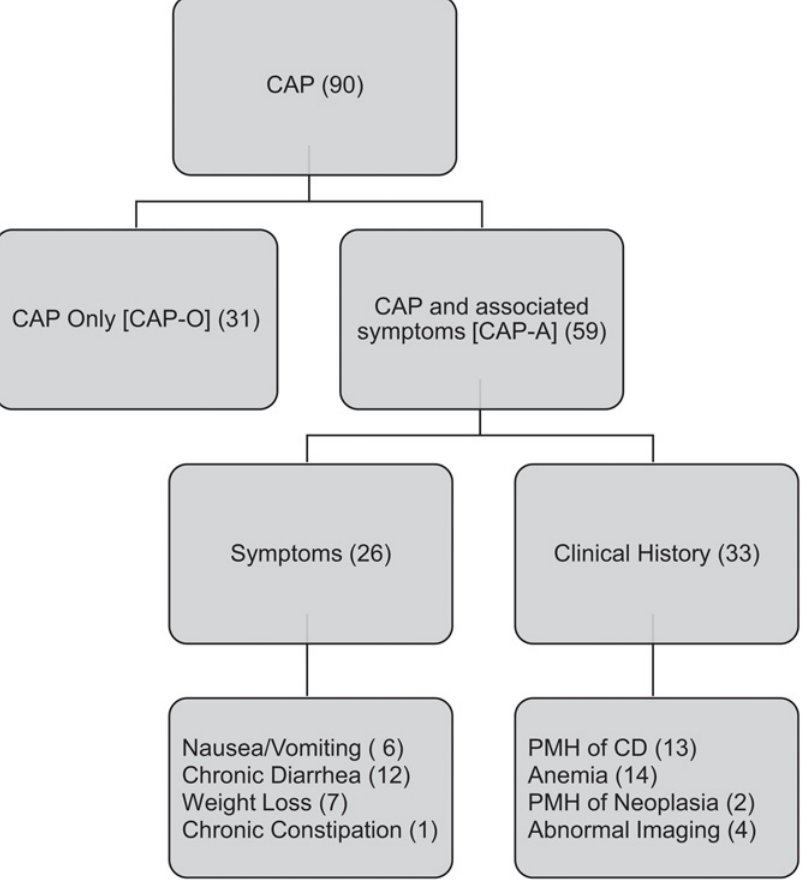
Fig 1. Flowchart with classification of patients with chronic abdominal pain (CAP), along with sub- group classification based on clinical presentation. Abbreviations: PMH (past medical history), CD (Crohn ’ s disease), UC (ulcerative